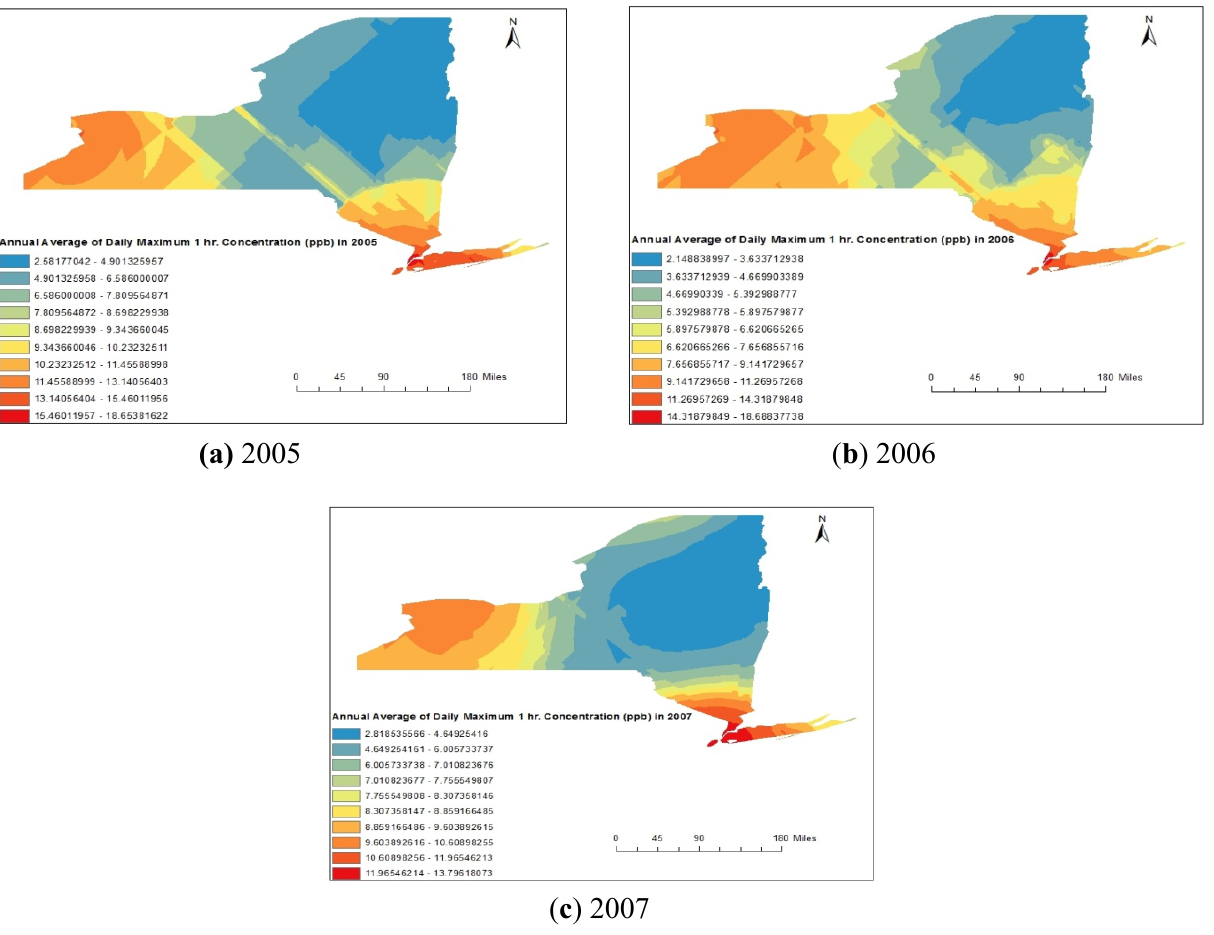
Figure 6. (a – c ) Spatial distribution of annual average maximum daily one hour SO concentrations during 2005 to 2007. 2